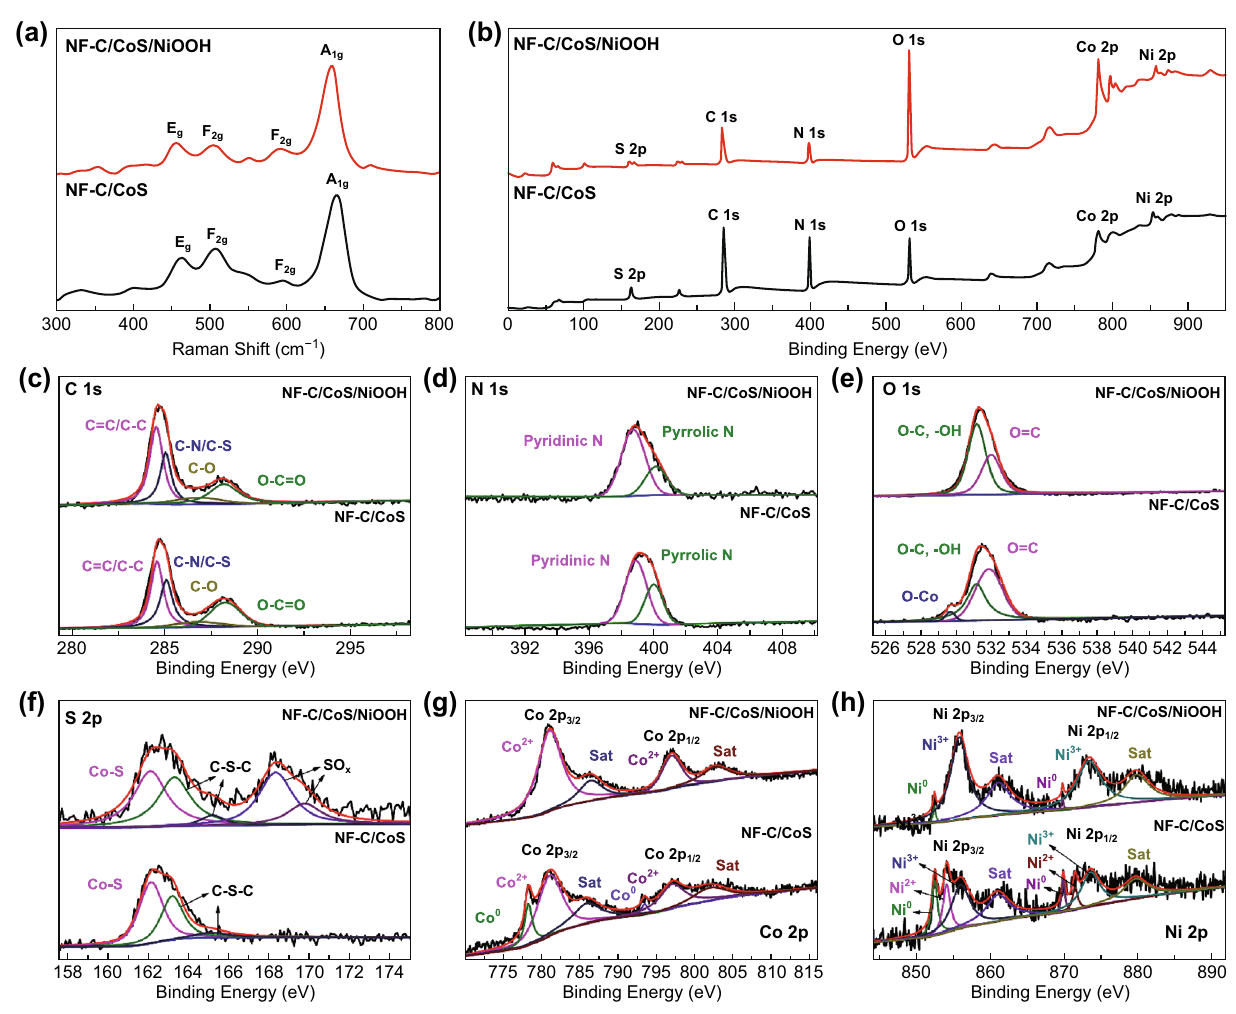
Fig. 3 a Raman spectrum of NF-C/CoS and NF-C/CoS/NiOOH. b XPS survey spectra of NF-C/CoS and NF-C/CoS/NiOOH. c C 1 s, d N 1 s, e O 1 s, f S 2p, g Co 2p, h Ni 2p of NF-C/CoS and